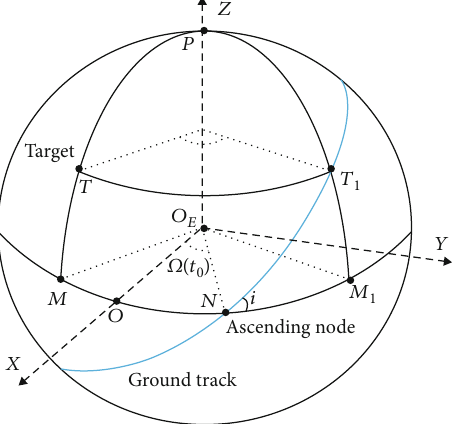
Figure 1: Monitoring during ascending